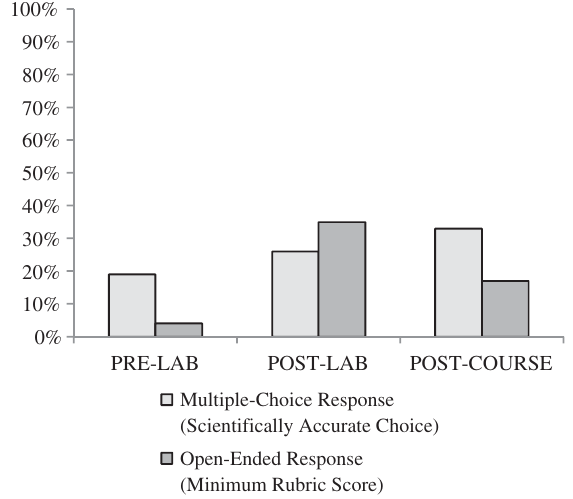
FIG. 8. Percentage of students meeting minimum criteria when asked to predict the phase of the Moon in two weeks given the current time and phase ( n ¼ 23 ).